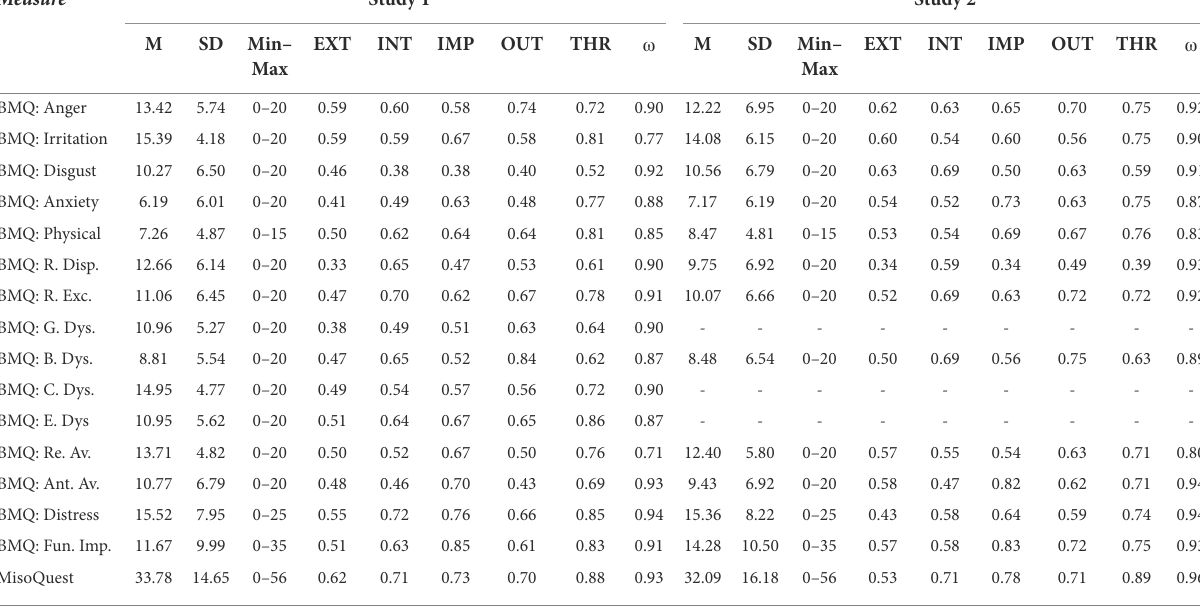
Table 4 Means and standard deviations, latent (Study 1) and Spearman’s (Study 2) intercorrelations, and reliability estimates of the BMQ-R symptom part, and MisoQuest.